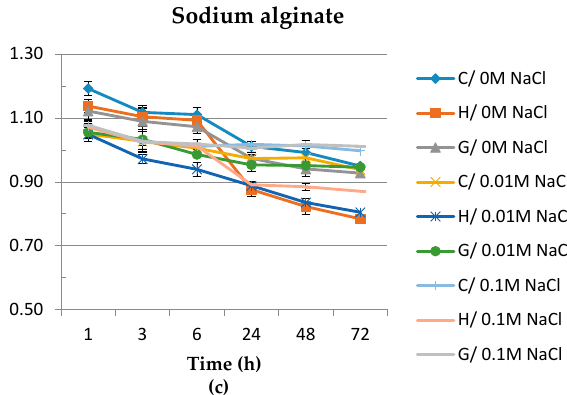
Figure 6. Swelling ratio of ( a ) 8% ( w / v ) gelatine + 0.2% ( w / v ) NaCl, ( b ) 2.5% ( w / v ) carrageenan + 0.2% ( w / v ) NaCl and ( c ) 1.25% ( w / v ) sodium alginate + 0.2% ( w / v ) NaCl in three variants of the gels: C, H, G (see description in the text), submerged in different NaCl concentrations.